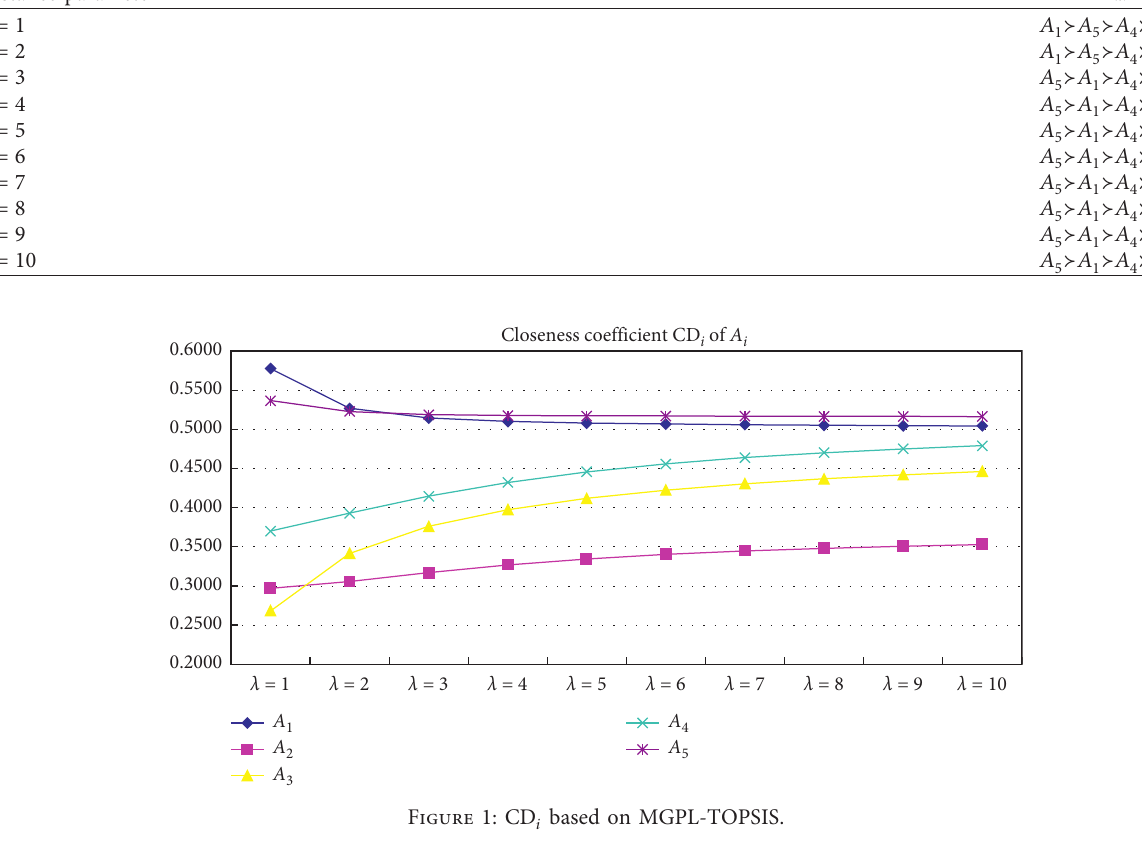
Table 13: The ranking of A